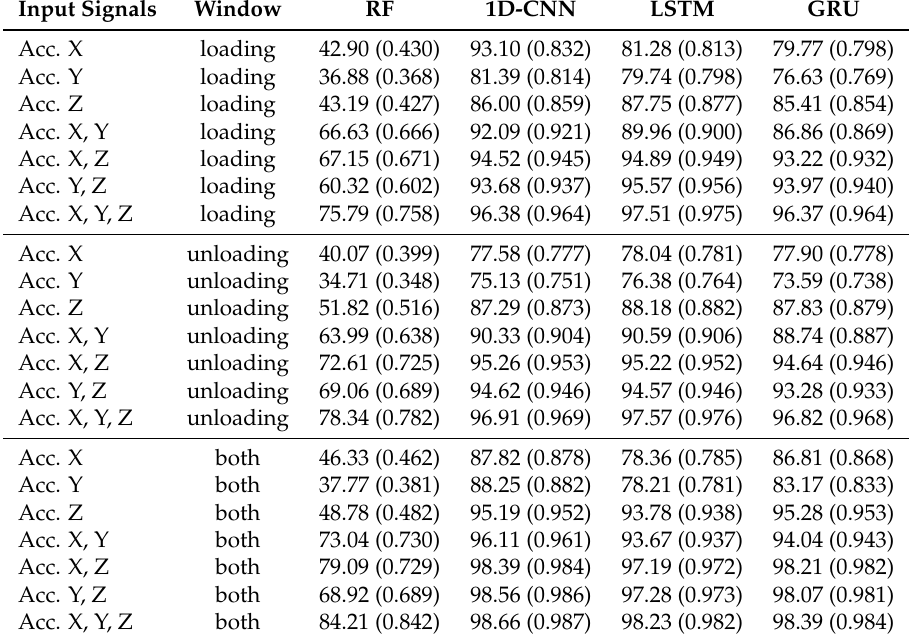
Table 2. Experimental results—test accuracy in percentage. The values in parentheses denote the f-measure score. Ten classes were reliably classified even when only one or two input signals were used. Notably, the results exhibited reasonable performance even when using only the loading motion (loading